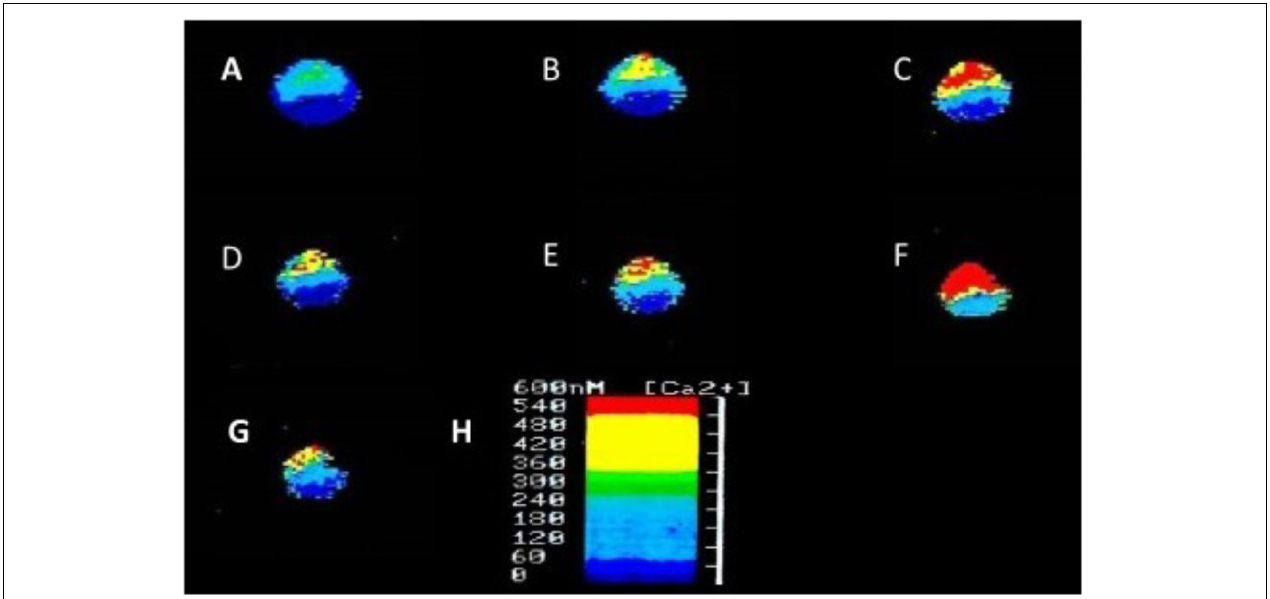
FIGURE 5 | Ratiofluorimetric images showing that Halothane raises intracellular calcium concentration in the cultured Lymnaea neurone RPD2 loaded with the fluorescent Ca 2 + indicator Fura 2. (A) Control in normal saline (101.18 nM [Ca 2 + ] I ); (B) 1 min after addition of 2% halothane (174.12 nM [Ca 2 + ] I ); (C) 5 min after 2% halothane (287.06 nM [Ca 2 + ] I ); (D) 10 min after washout of 2% halothane with normal saline (183.53 nM [Ca 2 + ] I ); (E) 1 min after 4% halothane (232.94 nM [Ca 2 + ] I ); (F) 5 min after 4% halothane (414.12 nM [Ca 2 + ] I ); (G) 15 min after washout of 4% halothane with normal saline (211.76 nM [Ca 2 + ] I ); (H) Fluorescence scale bar (From Ahmed, 1995 – Reproduced under the Creative Commons License).